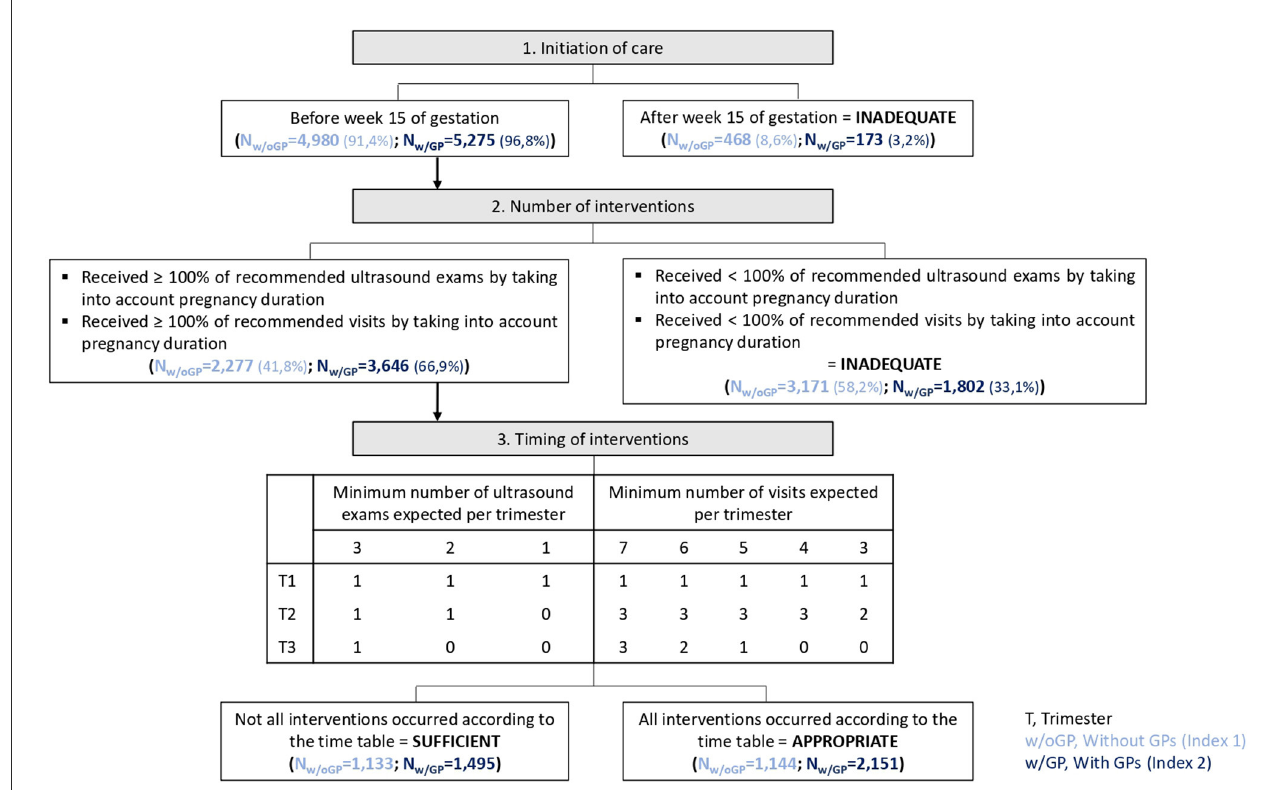
FIGURE1 Outline of the two new indices of prenatal care utilization and the corresponding results in the study population.